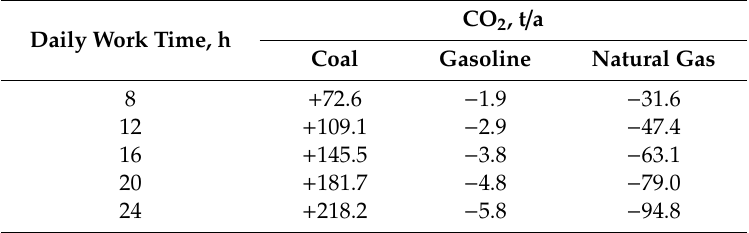
Table 2. Di ff erences in CO 2 emission during primary fuel combustion compared to straw combustion (“ + ” means higher emission, “ − ” means lower emission compared to straw combustion). Calculations based on emission factors given in [30]. CO 2 , t / a Daily Work Time, h Coal